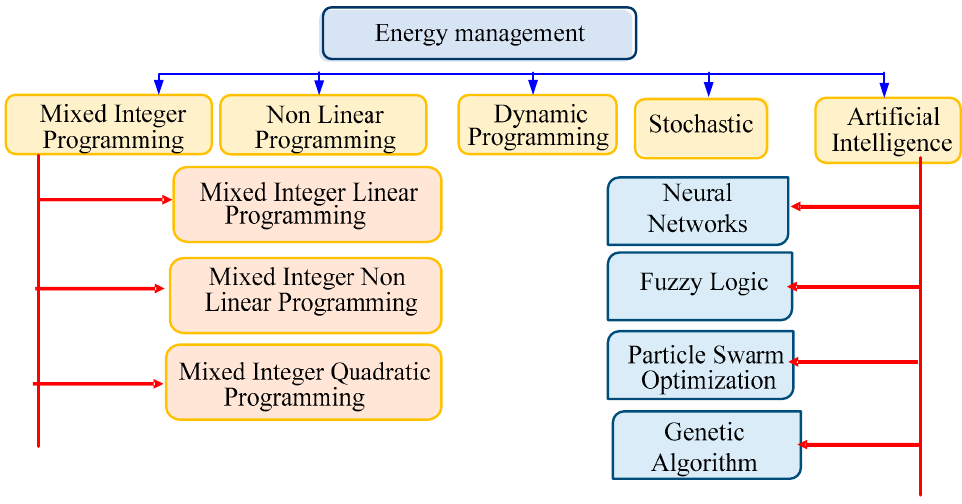
Figure 5. Energy management methodologies [99].